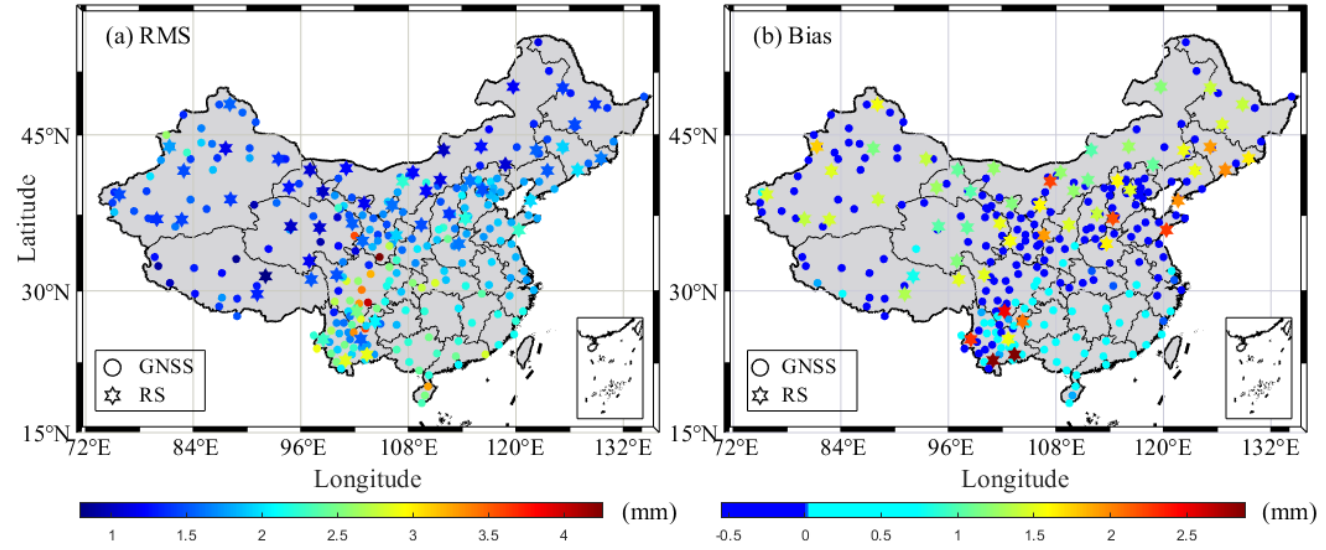
Figure 6. RMS and Bias distributions of PWV differences derived from ERA5 and GNSS/RS over the period of 2012–2020. Table 3. Statistical results of RMS, Bias, MAE of PWV differences between ERA5 and GNSS (260)/RS (87) in China over the period of 2012–2020.